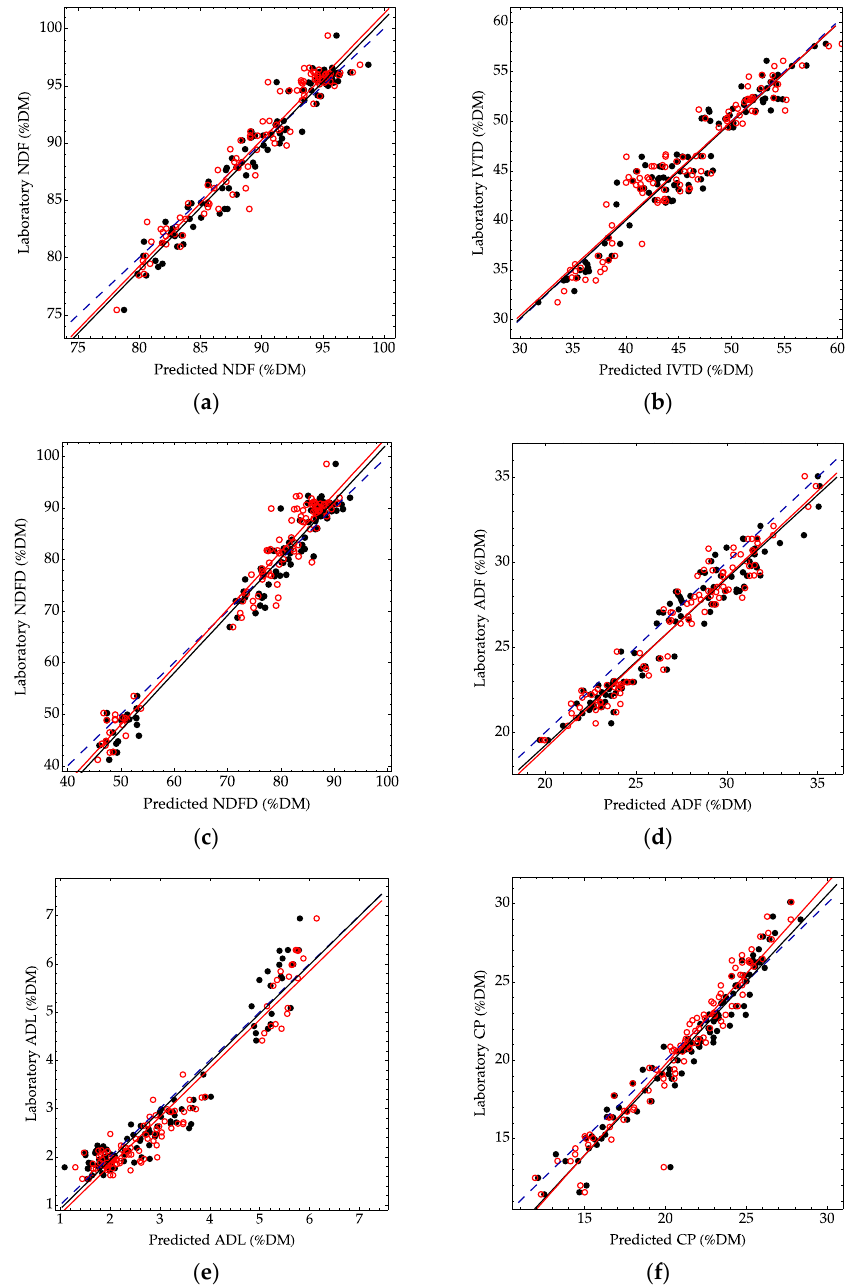
Figure 3. Validation scatter plots for an independent set of 20 alfalfa and 80 grass samples. Each point represents a laboratory result (( a ) NDF, ( b ) IVTD, ( c ) NDFD, ( d ) ADF, ( e ) ADL, ( f ) CP) compared to a predicted result using the mixed-species calibration model for the FOSS (solid black circles) and NEO (open red circles). The dashed blue line represents a 1:1 agreement between laboratory and predicted values. The solid black and red lines correspond to a linear model between the laboratory and predicted values for the FOSS (black) and NEO (red).